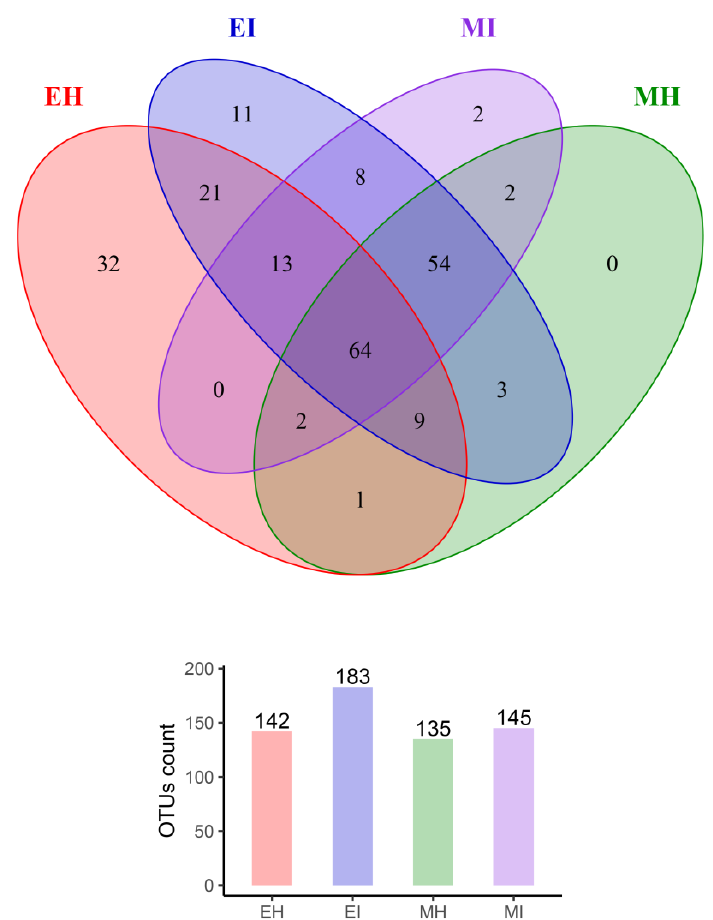
Figure 3. Venn diagrams of shared OTUs among different sample groups. (EH: emergence period, healthy; EI: emergence period, infested; MH: mating period, healthy; MI: mating period,